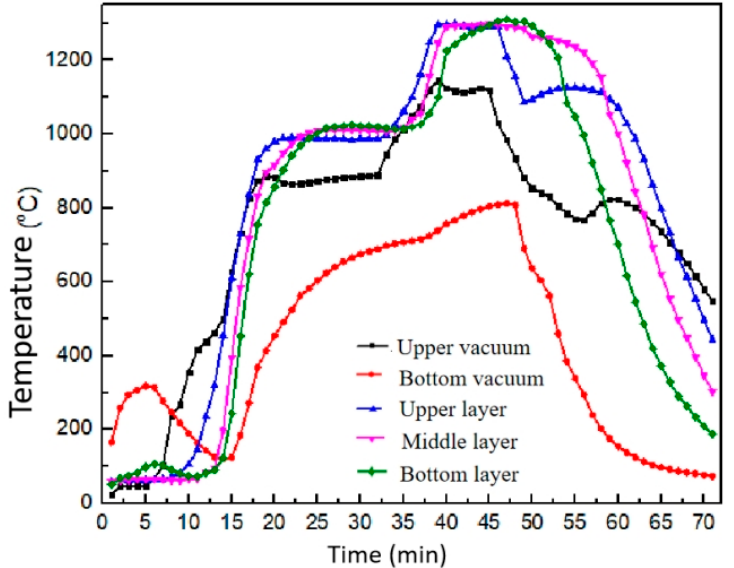
Figure 6. Typical temperature curves of the simulated straight-grate experiment using HA binder.